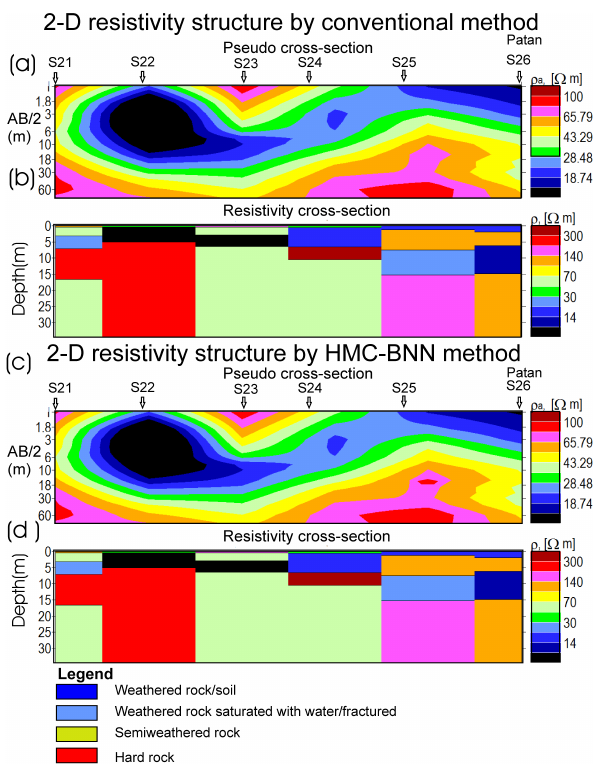
Fig. 11. Resistivity structure of sounding points s21–s26 by (a, b) singular value decomposition (SVD)-based conventional method. (c, d) Hybrid Monte Carlo (HMC)-based Bayesian neural network (BNN)